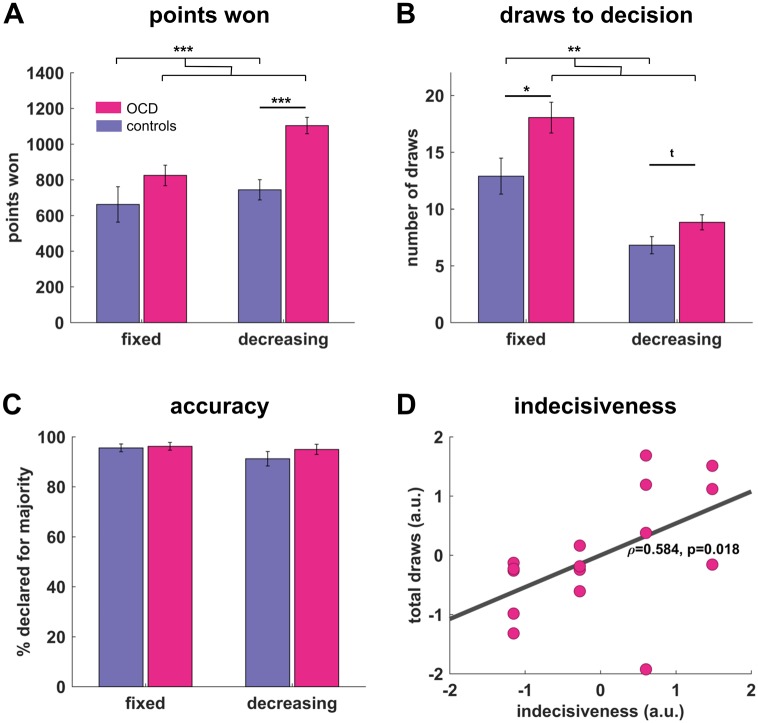
Performance differences in information gathering.Adolescents with OCD won significantly more points than controls across the entire task. This was mainly driven by an increase in points won during the decreasing condition (A). OCD patients opened significantly more boxes (B), but did not differ in performance accuracy (C; accuracy defined as the proportion of choices of the colour that was in the majority of currently opened cards). (D) Total draws to decision correlated significantly with self-reported general indecisiveness in OCD patients, linking task behavior to real-world perceived difficulties. *** p< = .001, ** p < .01, * p < .05, t p < .10.